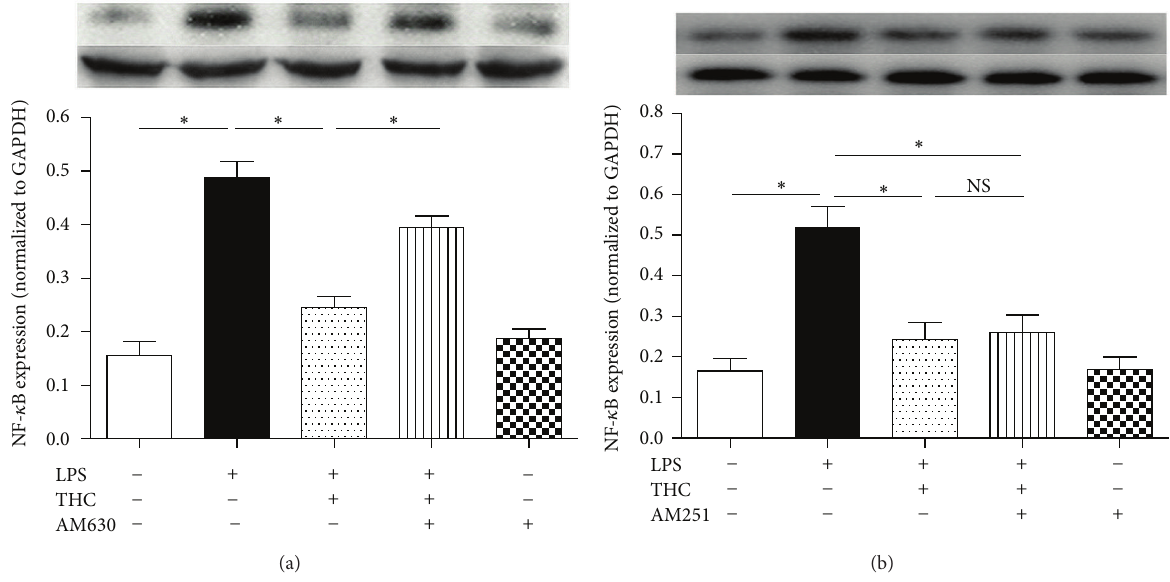
Figure 5: THC reduced NF- 𝜅 B expression via CB2 receptor in LPS-stimulated MG-63 cells. NF- 𝜅 B expression was assessed by western blot. THC reduced LPS-induced upregulation of NF- 𝜅 B expression, and CB2 antagonist AM630 (a), not CB1 antagonist AM251 (b), partially abolished this effect. Results are means ± SD, ( 𝑛 = 6 ). ∗ : 𝑃 < 0.05 ; NS: no